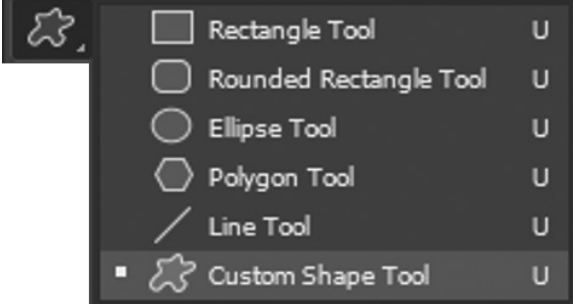
Figure 19. Shape tool group expanded to show all hidden tools.